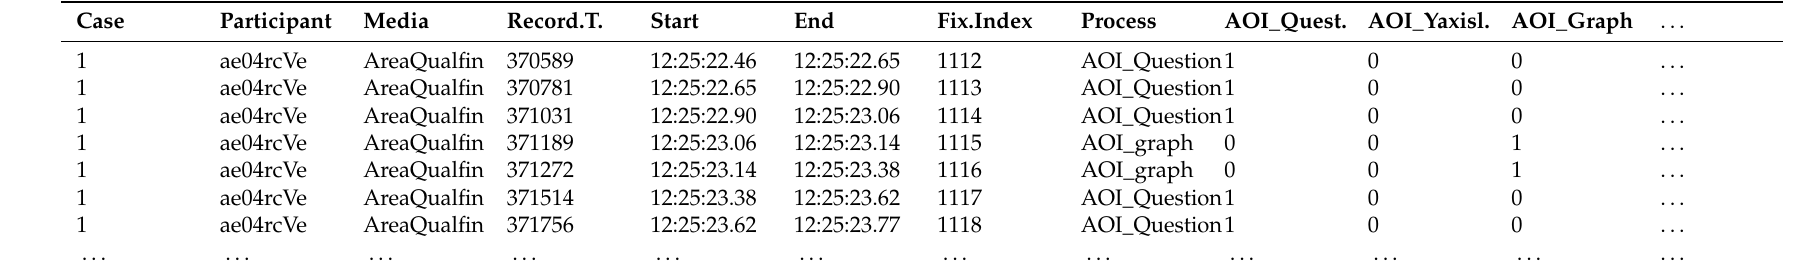
Table 1. Sample extract of the analyzed